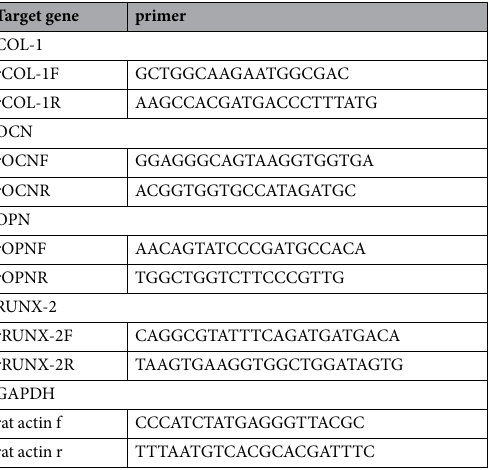
Table 1. Real-time polymerase chain reaction primers used in this